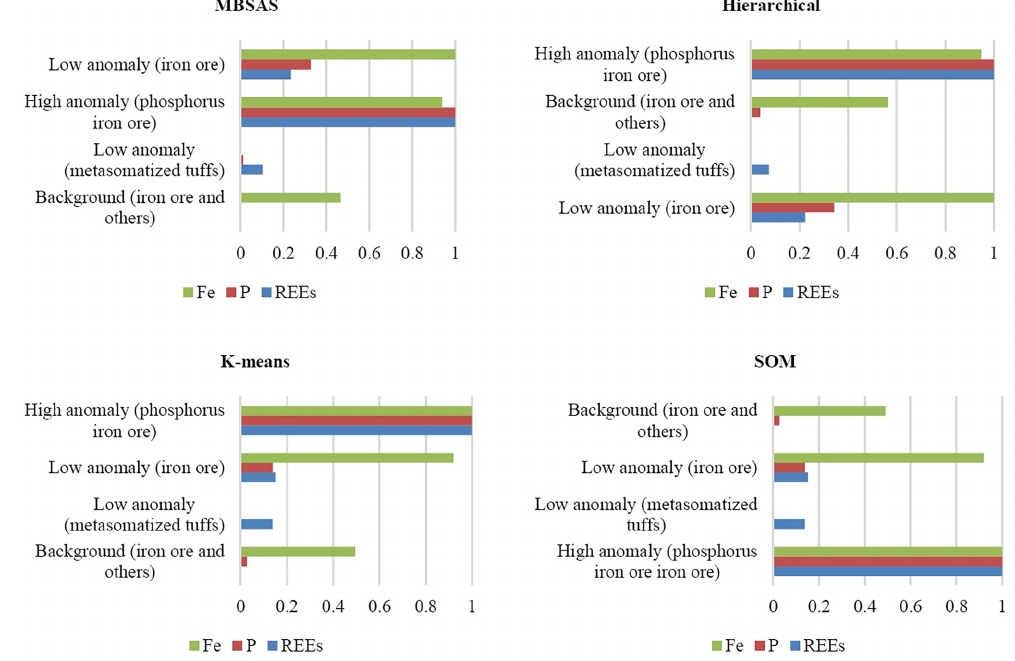
Figure 6. Comparative bar charts of normalized values of REE, P and Fe for all clustering